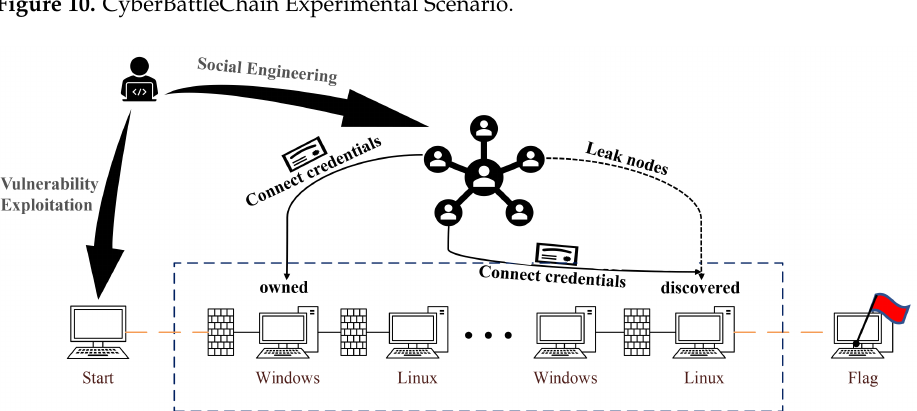
Figure 11. CyberBattleChain Experimental Scenario with Social Engineering